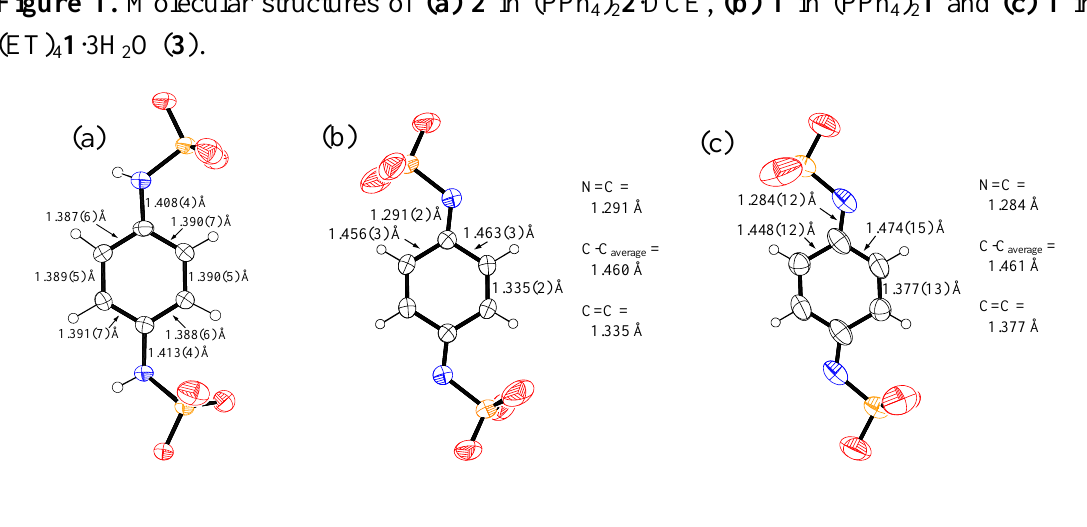
) 1 and (c) 1 in 4 2